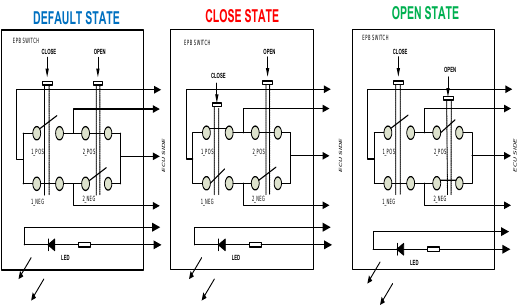
Figure 4 Three basic states of EPB electromechanical switch, adopted from [2]. OPEN state = RELEASE of brake, CLOSE state = APPLY of